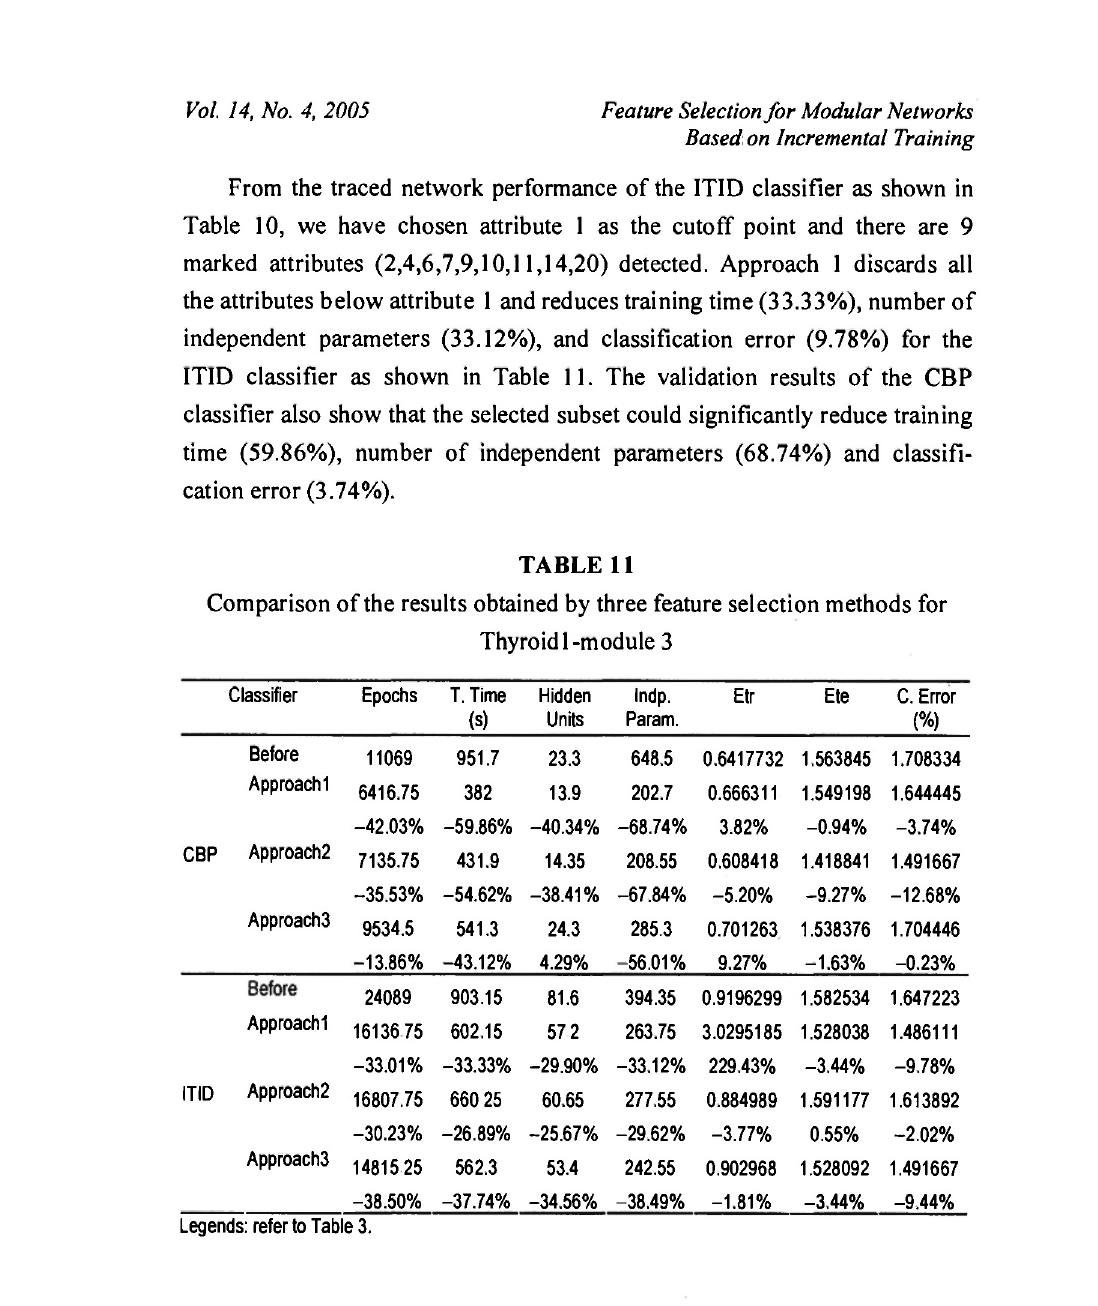
Legends: refer to Table